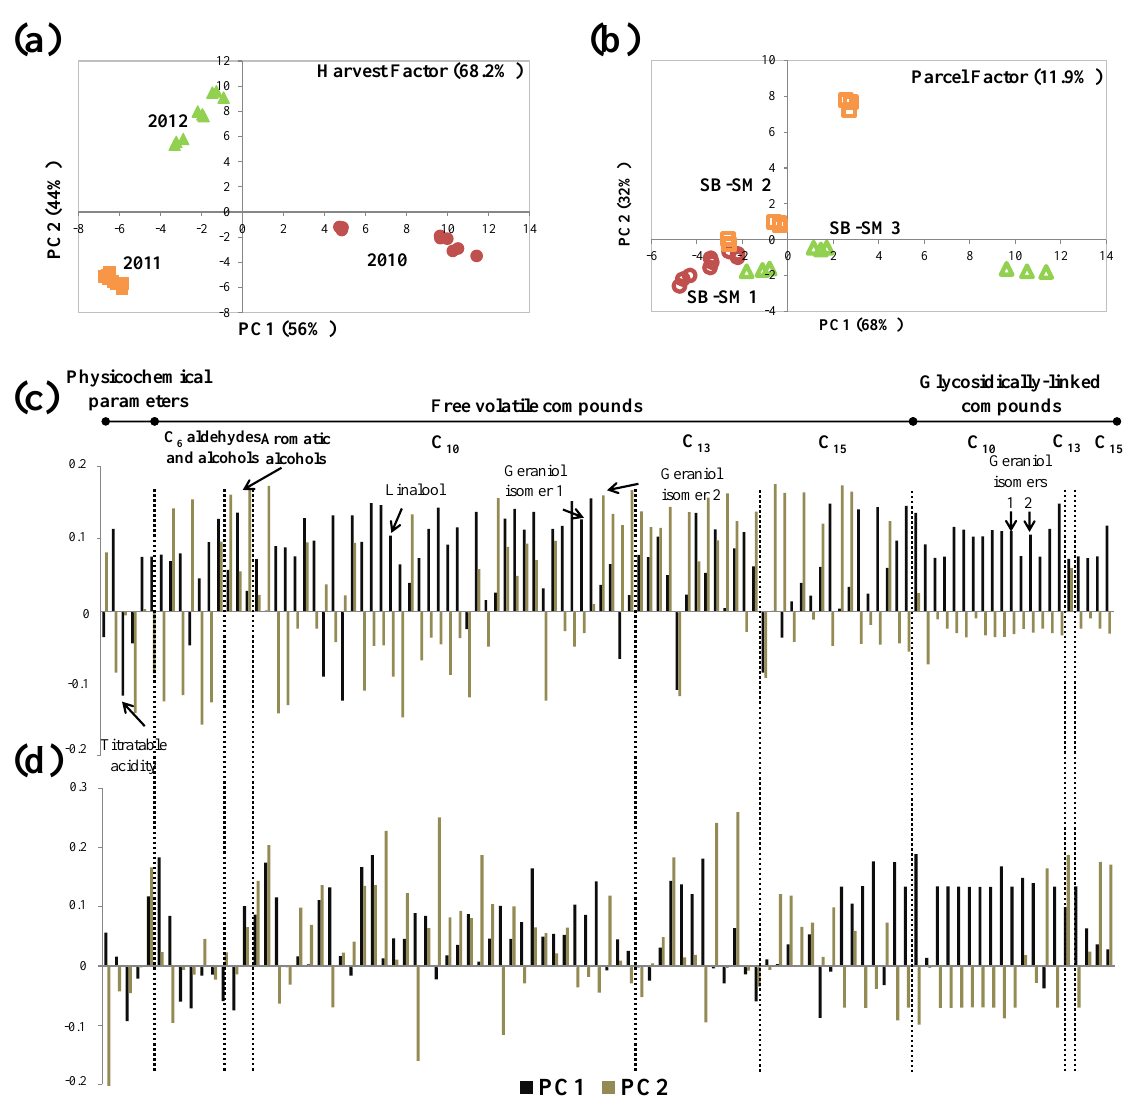
Figure 6. ASCA scores plot for ( a ) harvest factor and ( b ) parcel factors, and the corresponding variable loadings plot ( c , d ), respectively, obtained for Sauvignon Blanc, at technological maturity (significance test reported on Table 4). Each variable is normalized separately by dividing by its standard deviation value. Baga The effect of the harvest year accounted for 61.4% of total data set variance (Table 4). The first component of scores plot separates the 2010 harvest (PC1 positive) from the oth- ers (PC1 negative), while the second component separates 2011 and 2012 harvests (Figure 7a). The loadings plot (Figure 7c) showed that 2010 was differentiated by the higher con- tent of monoterpenic compounds. From these, β-ocimene, α-terpinolene, rose oxide, 1- terpineol, nerol oxide, digydrocarvone, menth-1-en-9-al, and carvone were detected only in 2010 grapes. The higher content of C 13 norisoprenoids and sesquiterpenic compounds was responsible for the separation of the 2012 harvest from 2011 along the PC2. Addition- ally, grapes from 2011 (PC2 negative) also exhibited higher titratable acidity and sugar content compared to the other harvests. The obtained results highlighted the sensitivity